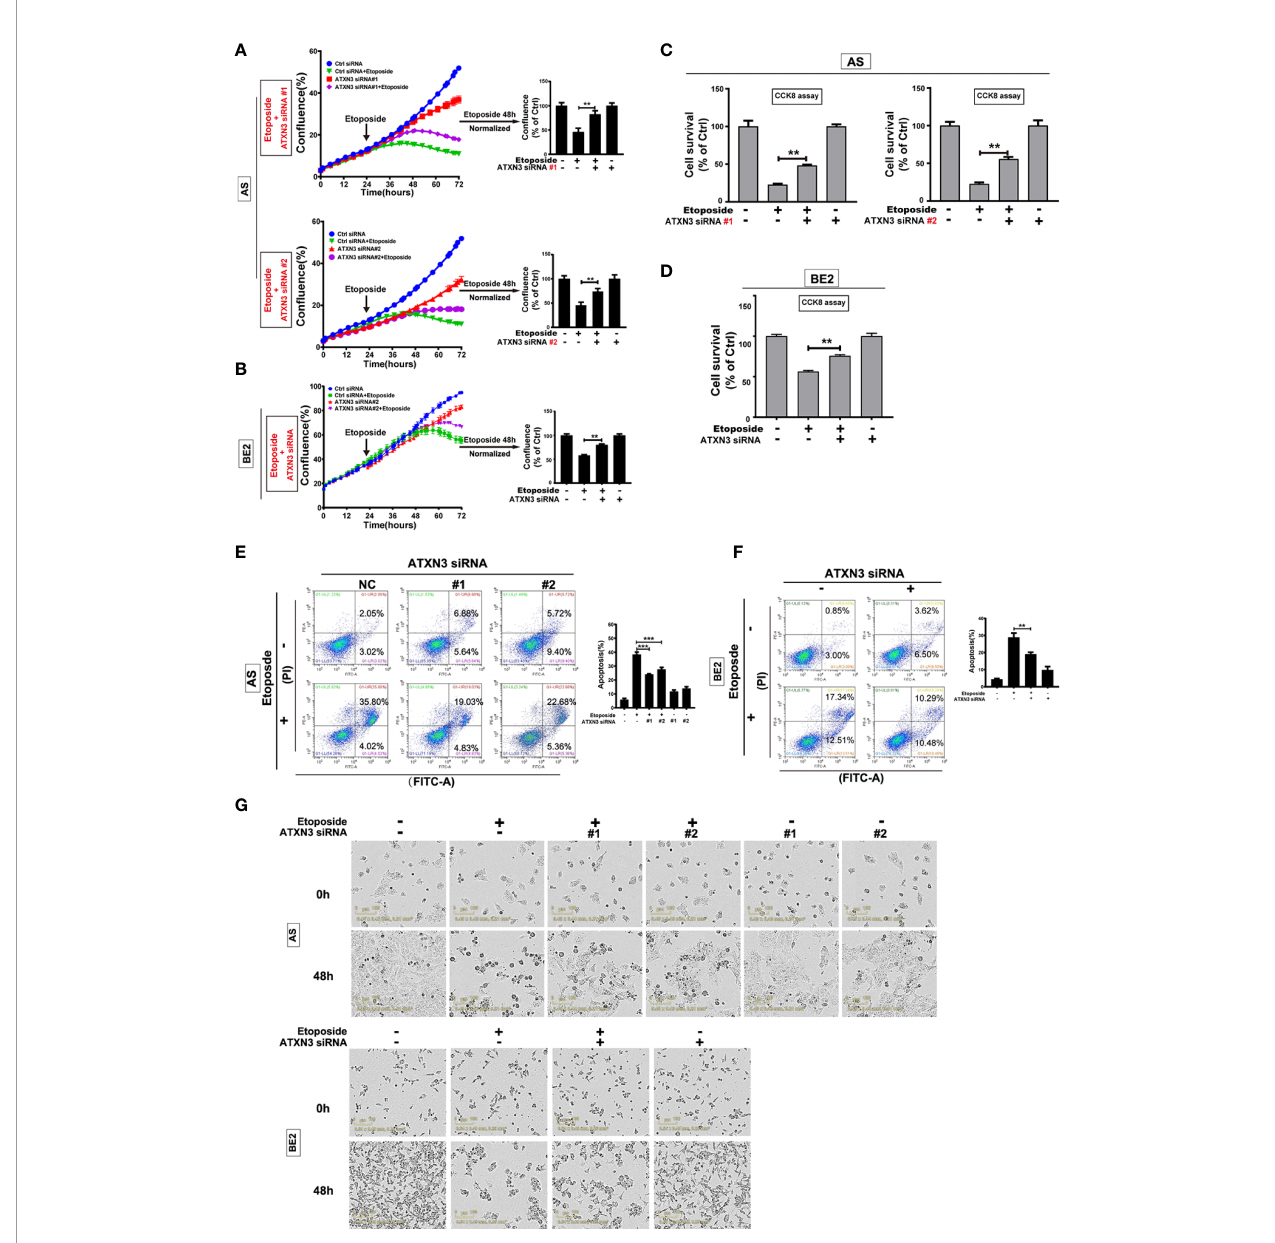
FIGURE 4 | Downregulation of ATXN3 decreased the sensitivity of NB cells to etoposide. AS cells were transfected with ATXN3 siRNAs (#1, #2) and BE2 cells were transfected with ATXN3 siRNA #2 (marked as ATXN3 siRNA) for 16 h, followed by 48 h treatment of etoposide. (A, B) Cell con fl uence was dynamically detected and analyzed by IncuCyte Zoom; (C, D) Cell survival was detected by CCK8 assay; (E, F) Cell apoptosis was detected by Annexin V/PI fl ow cytometry; (G) The images of AS and BE2 cells with ATXN3 siRNAs transfection and etoposide treatment at 0 h and 48 h were recorded. Bar, SD, ***, P<0.001, **, P<0.01, ATXN3 siRNAs + etoposide vs. control siRNA +